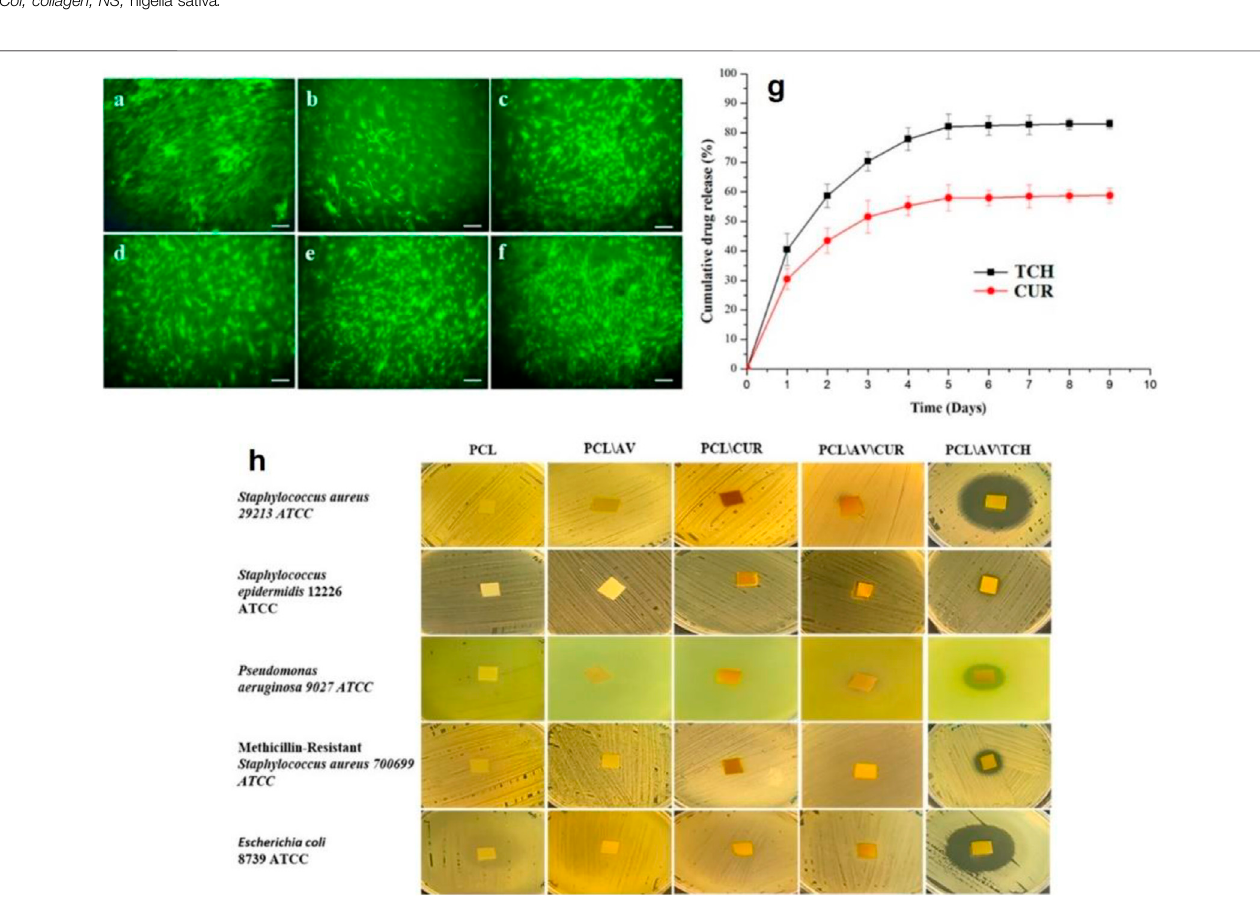
FIGURE2| Live fi broblastcellspresent on (A) control, (B) PCLnano fi bers, (C) AV/PCLnano fi bers, (D) CUR/PCL nano fi bers, (E) AV/CUR/PCLnano fi bers,and (F) AV/TCH/PCL nano fi bers (scale bars represent 50 µm). (G) TCH and CUR release pro fi les of the AV/CUR/PCL and AV/TCH/PCL nano fi bers over a 9-days time period. (H) Antibacterial activity of the drug loaded PCL nano fi ber systems. The images were reproduced under CC BY licence (Ezhilarasu et al., 2019), Copyright 2019, MDPI.